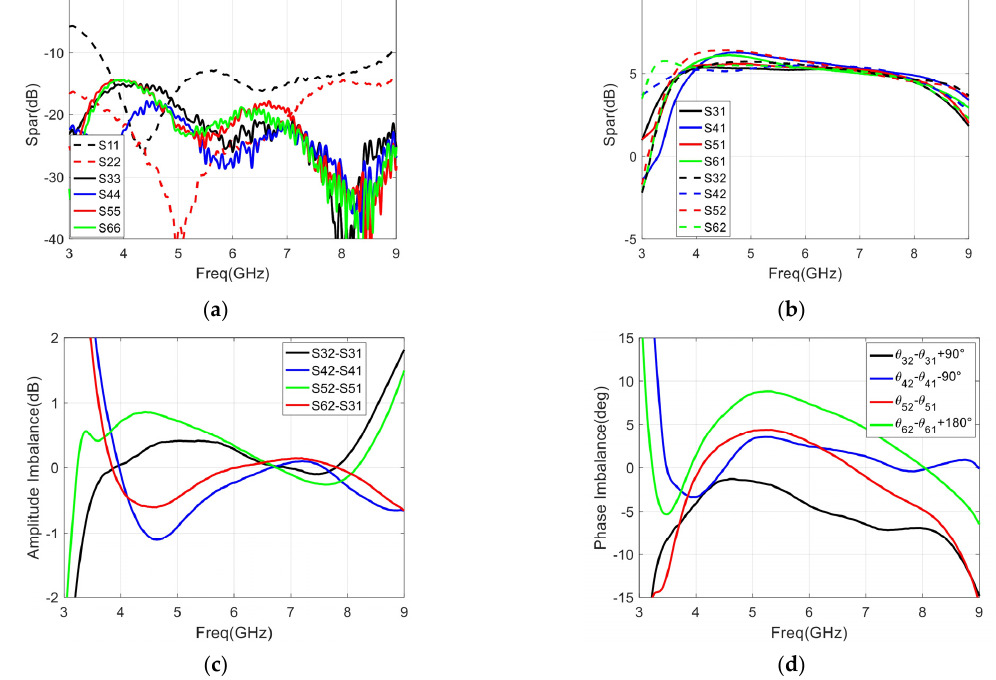
Figure 10. The measurement result of the six-port circuit: ( a ) Return loss of each port; ( b ) Gain of the integrated six-port circuit; ( c ) The amplitude imbalance of the six-port circuit; ( d ) The phase imbalance of the six-port circuit.